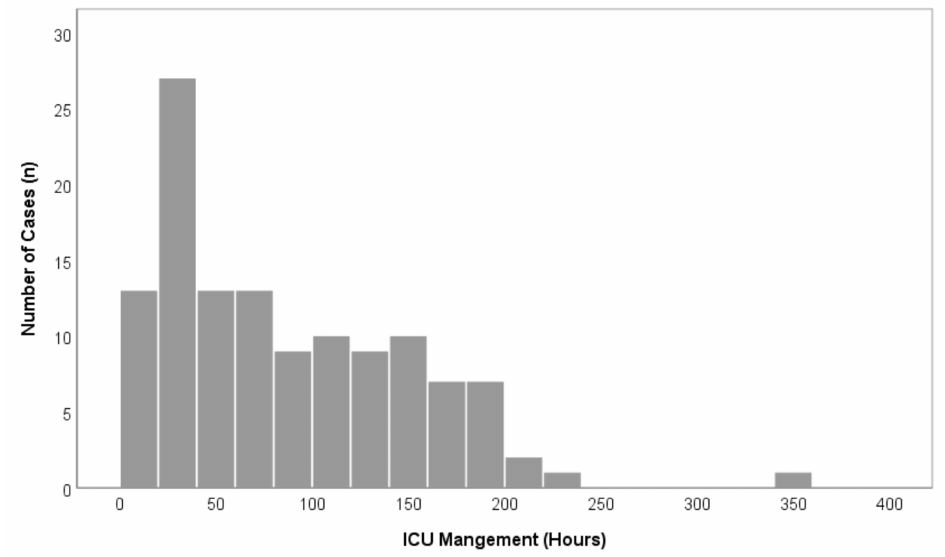
Figure 3. Overview of overall case distributions in comparison to ICU-LOS ( n =